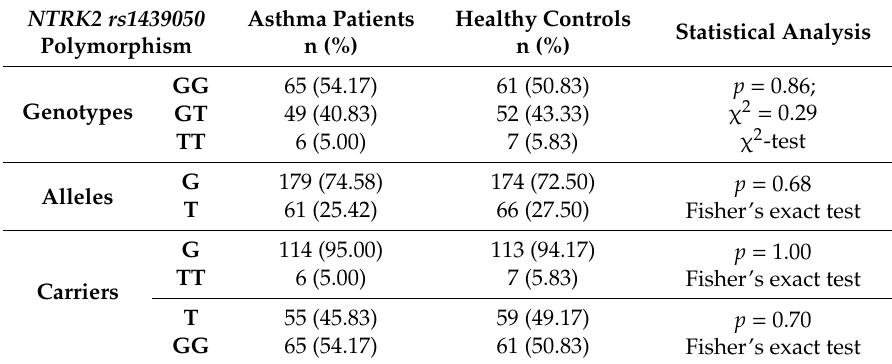
Table 4. Distribution of genotypes, alleles and carriers of NTRK2 rs1439050 polymorphism in asthma patients and healthy